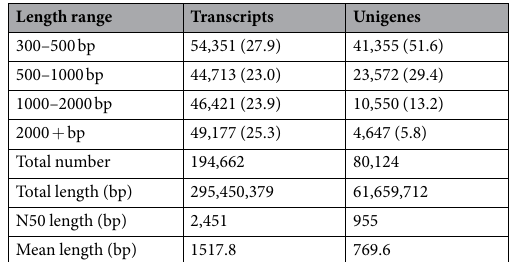
Table 4. Summary of assembled transcripts and unigene data of Heterodera avenae in the study. The number in brackets indicates the percentage of the transcripts or unigenes in that length range.